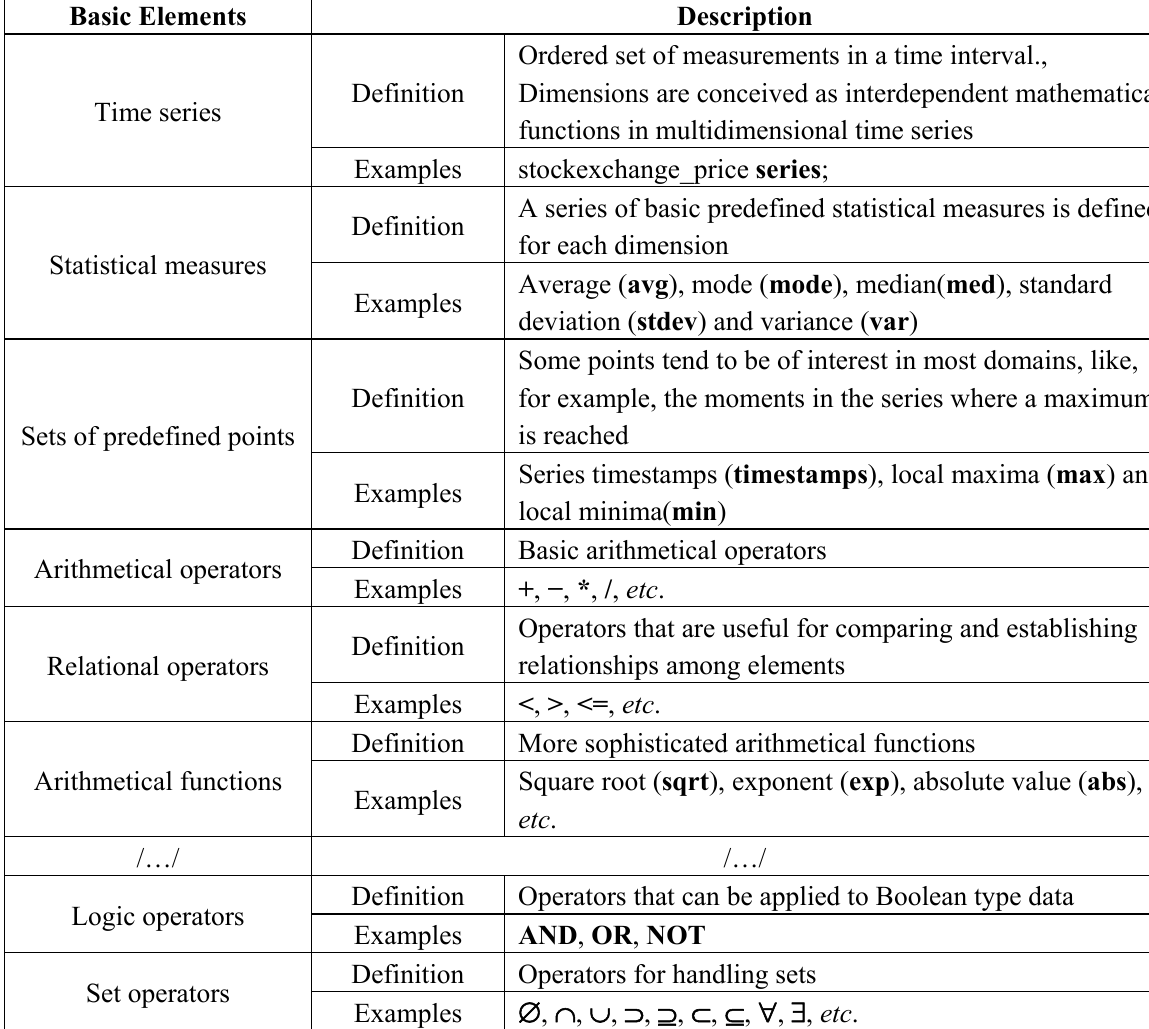
Table 1. Basic events definition language